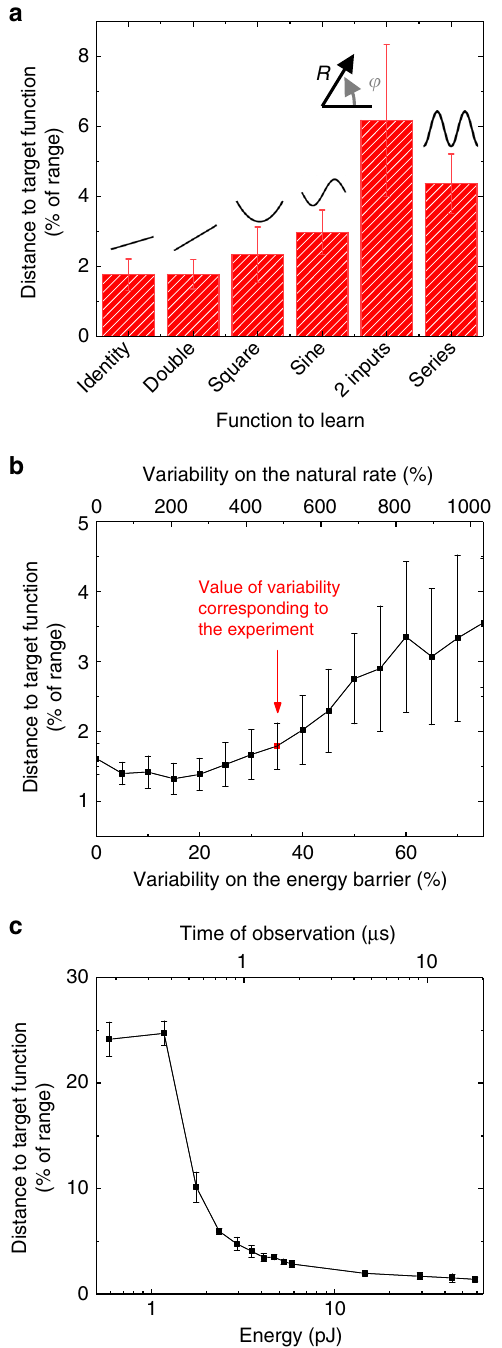
Fig. 4 Evaluation of stochastic population coding with superparamagnetic tunnel junctions. a Performance of several transformations, including non- linear. The 2 inputs label corresponds to transformation from polar to Cartesian coordinates. The series label corresponds to two transformations in series implementing the function sin 2 ( x ). b Distance to target versus variability of the energy barrier (bottom axis) and variability of the natural frequency (top axis). The experimental variability is indicated in red. c Distance to target for different times of observation during which switching rates are recorded, leading to different energy dissipated by the junctions (see Methods). Longer acquisition time allows better precision of the transformation, but leads to higher energy consumption. Each population is composed of 100 junctions and 3000 learning steps are used. Each data point corresponds to the average over 50 trials and the error bar to the associated standard